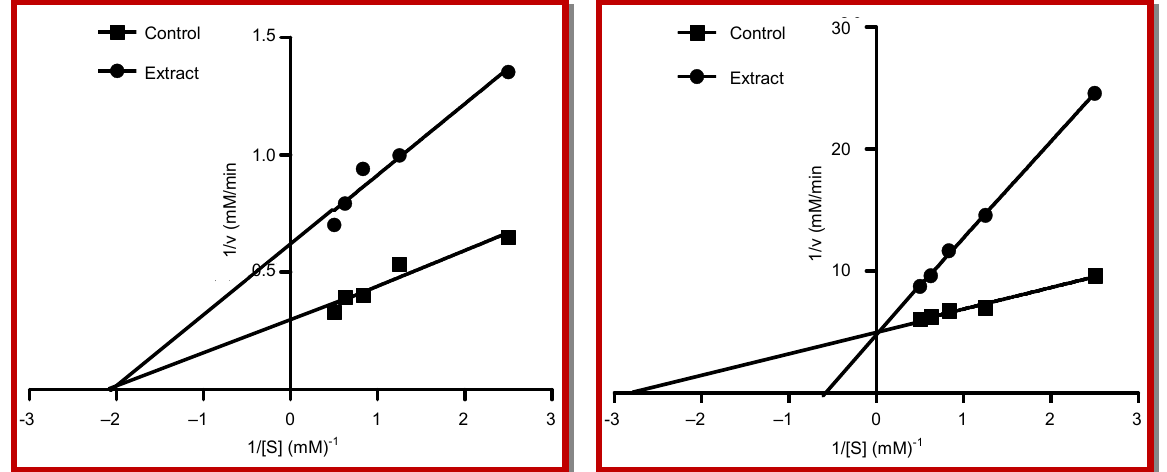
Figure 2: Mode of inhibition of α - glucosidase by ethanol extract of Cephalaria gigantea